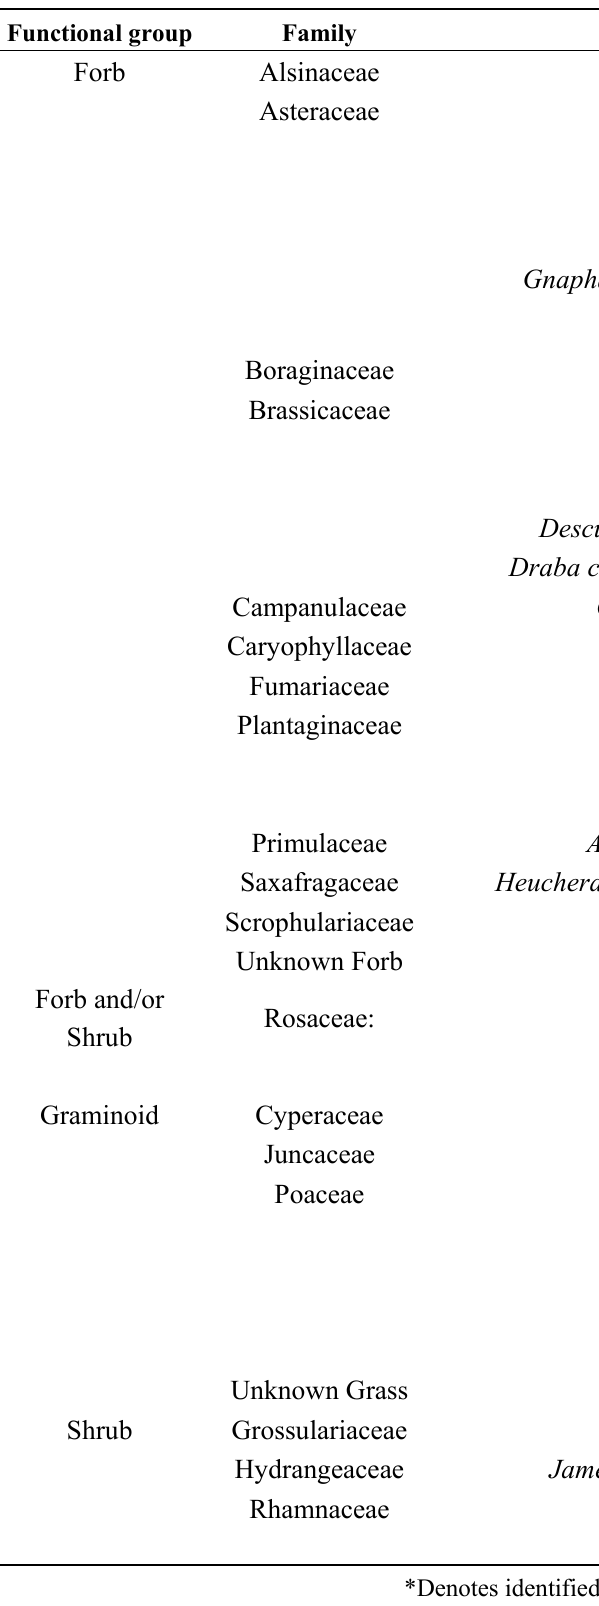
Table 1. Raw counts of seeds found in mineral soil grouped by functional group, family and genus (identified to species if positive identification was available). Each family has the total number of seeds observed including individuals that were identified